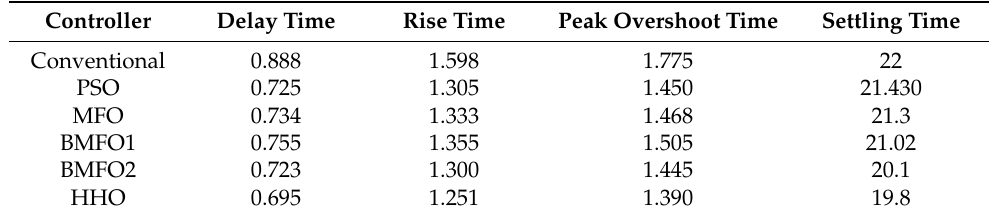
Table 8. Graph analysis of GENCOs generation response of Area2 with various controllers under unilateral contract.